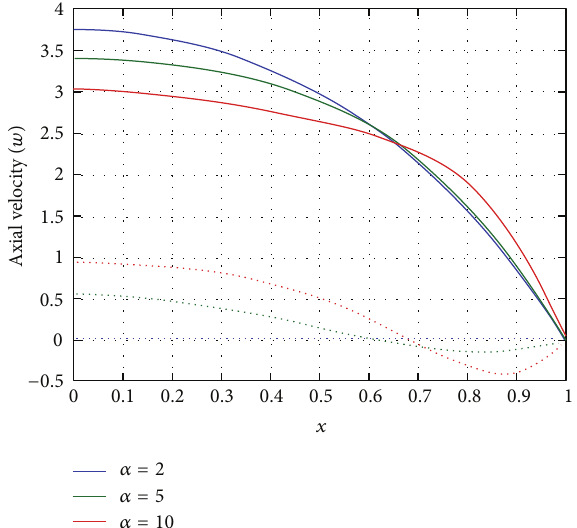
Figure 10: Variation of unsteady axial velocity profile at the peak (solid lines) and minimal (dotted lines) velocity for different Wom- ersley parameter 𝛼 , with Re = 100 and Ha = 2 .